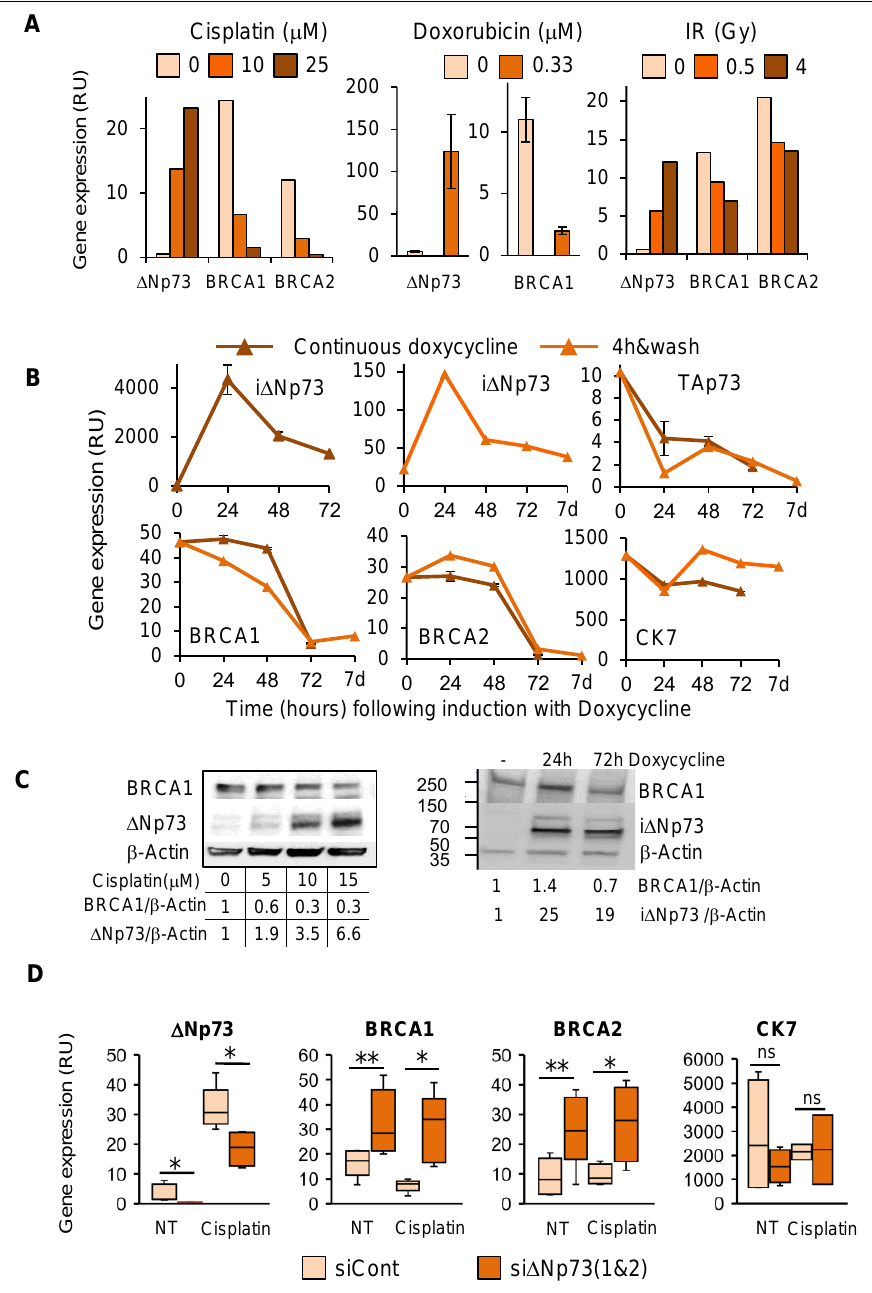
Figure 6. Induction of deltaNp73 corresponded with a decrease in BRCA1 and BRCA2 gene expression. ( A ) DeltaNp73 expression (mRNA) was induced, while BRCA1/2 expression was reduced in MCF10A following exposure to various DNA damaging agents for 24 h. Error bars represent the mean ± S.E.M when the experiment was repeated three times. ( B ) Overexpression of exogenous deltaNp73 in MCF10A was accompanied by reduction in BRCA1 and BRCA2 expression 72 h post exposure to 0.01 μg/mL doxycycline. TAp73 was reciprocally reduced while CK7 remained at high levels. ( C ) BRCA1 protein was reduced as deltaNp73 increased in cisplatin treated MCF10A (left) and 72 h post induction of MCF10A with doxycycline. Western blot data were quantified by ImageJ software and deltaNp73 values were normalized beta-Actin and calculated as relative folds of deltaNp73 in the untreated MCF10A (no cisplatin, no doxycycline). ( D ) Inhibition of deltaNp73 in MCF10A by siRNA was associated with increased BRCA1 and BRCA2 gene expression (mRNA). MCF10A were transfected with siControl or si D Np73, incubated for 24 h, and then, treated with 15 μM cisplatin for additional 24 h before RNA extraction. Gene expression was measured by RT-qPCR and normalized to GAPDH (RU = 2 D CT × 10 4 ). Box plot lower and upper limits represent the Q1 and